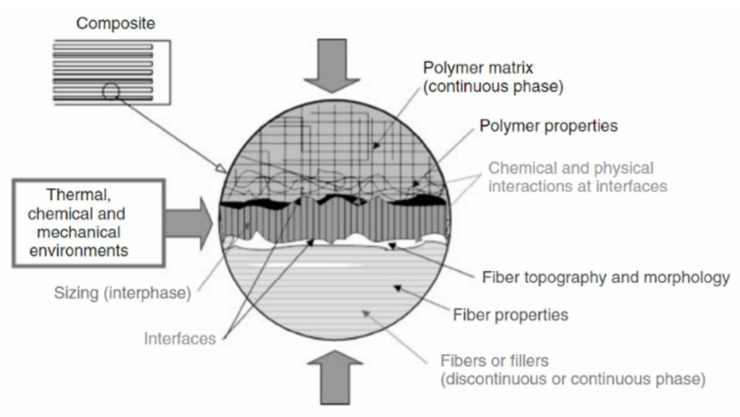
Figure 1. Schematic illustrating interface of fiber/matrix composite. Reproduced with permission from [12]. Copyright 2013 John Wiley and